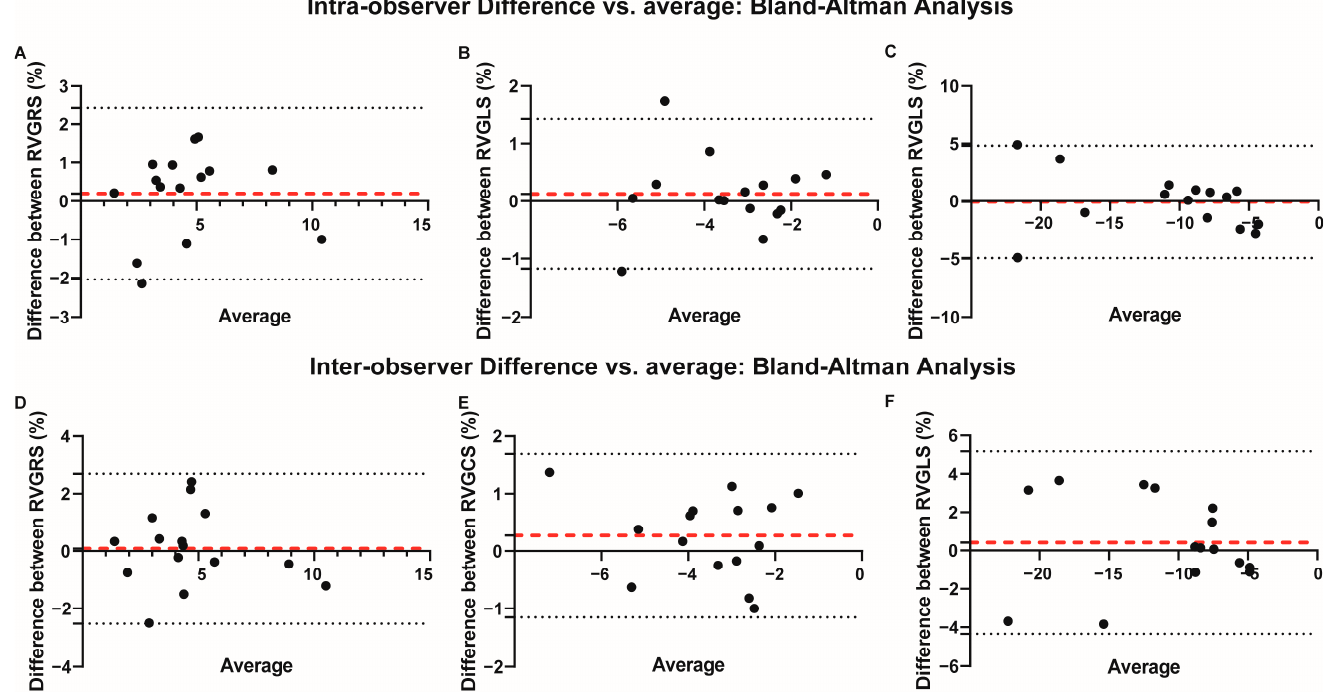
Figure 4. Bland–Altman analysis of RV strain for intra ‐ and inter ‐ observer variability. ( A – C ) Variability of intra ‐ observer for RVGRS, RVGLS and RVGCS quantification. ( D – F ) Variability of inter ‐ observer for RVGRS, RVGLS and RVGCS quantification. Red dashed line: bias error; black dashed lines: 95 % limits of agreement.